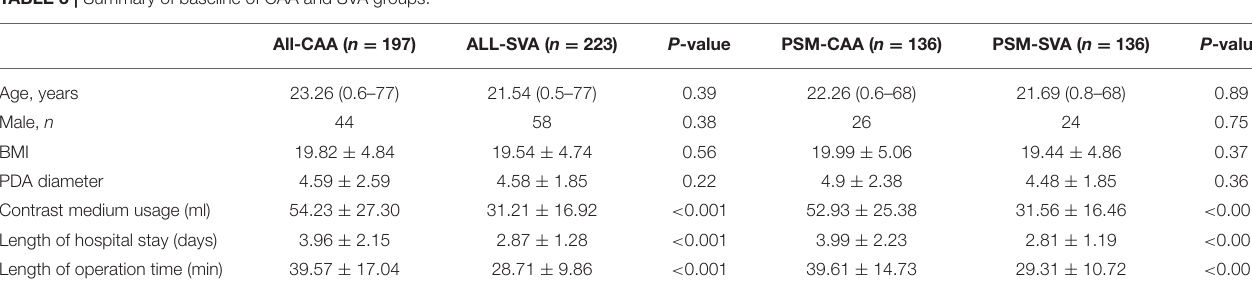
TABLE 3 | Summary of baseline of CAA and SVA